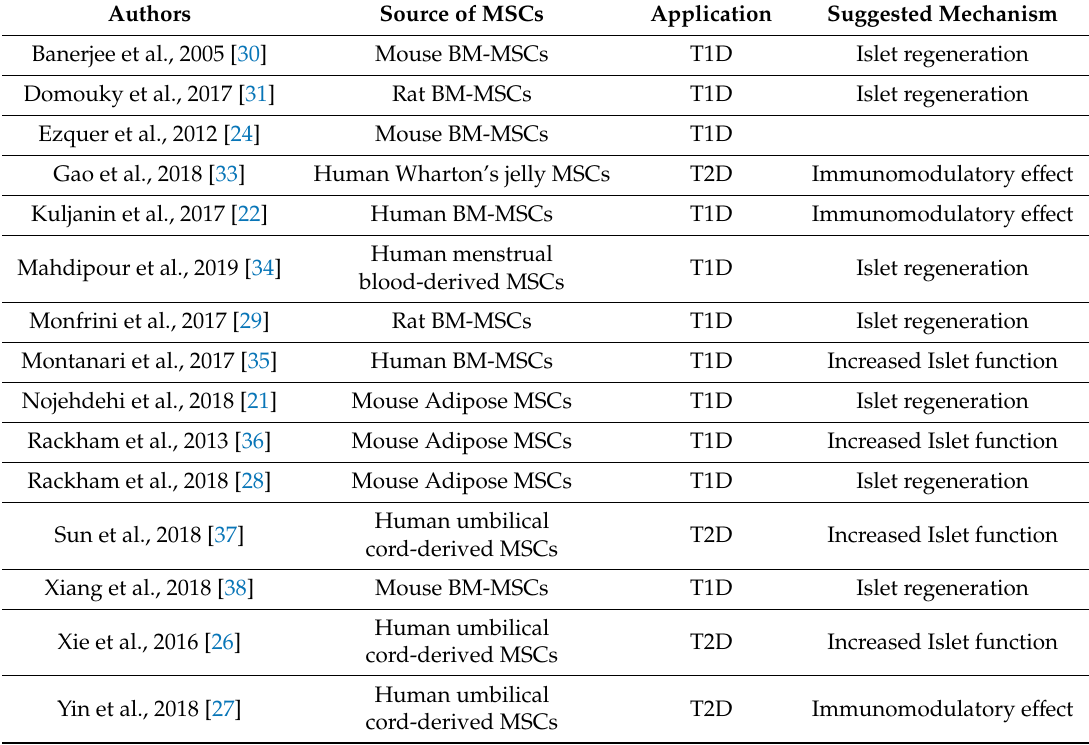
Table 1. In vivo studies on MSC and